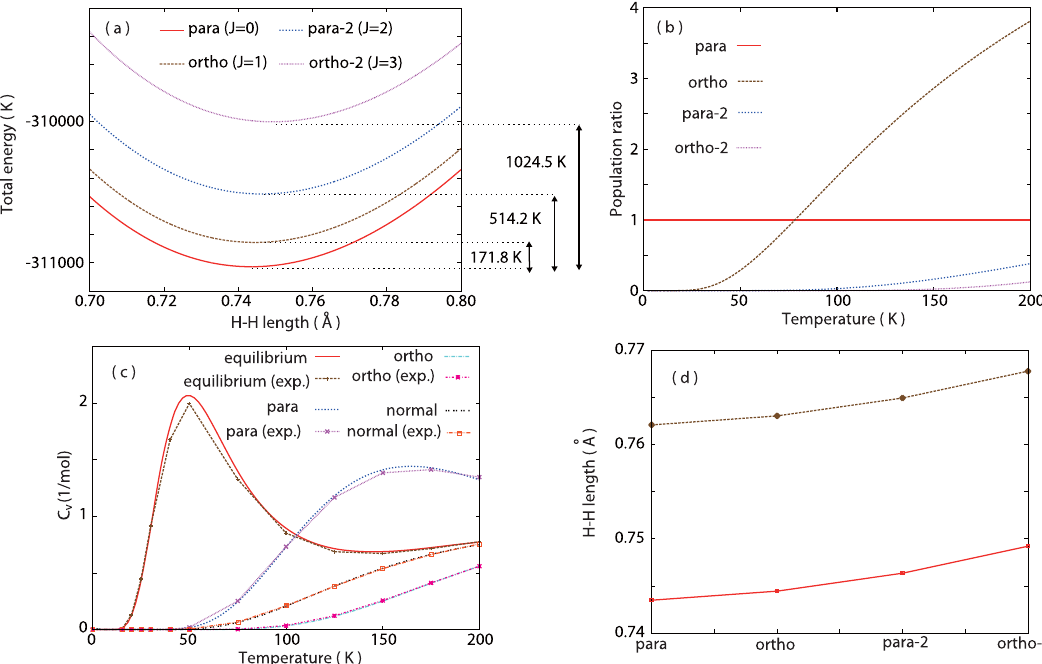
Fig. 2 Energy and structure of para, ortho, para-2, and ortho-2. a Total molecular energy as a function of the H-H bond length R rel with the difference of the minimum molecular energy estimated from the basins of the total energy curves. b Population ratios of the shell-type species as a function of temperature relative to the para population in a dilute gas phase. c Rotational speci fi c heat at constant volume, C v , as a function of temperature for the equilibrium population ratio shown in ( b ) (red line), for the para and para-2 population only (blue line), for the ortho and ortho-2 population only (light blue line), and for the normal population ratio composed of 25 % C v of para and para-2 and 75 % C v of ortho and ortho-2 (black line). The corresponding results obtained from the experimental data are also shown as points with a line for comparison. d Stable H-H bond length at the energy minima in ( a ) (red line) as well as the quantum H-H bond length taking into account the NWP delocalization (brown